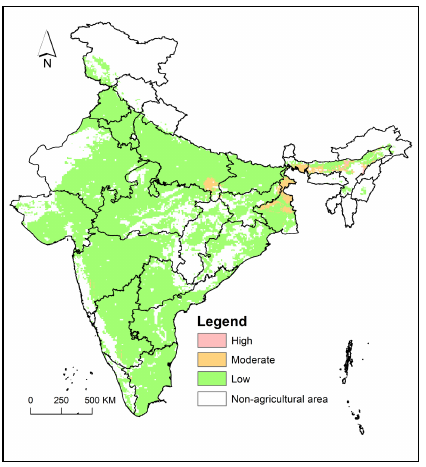
Figure 14 Trends of meteorological drought extent during 1982-2015.